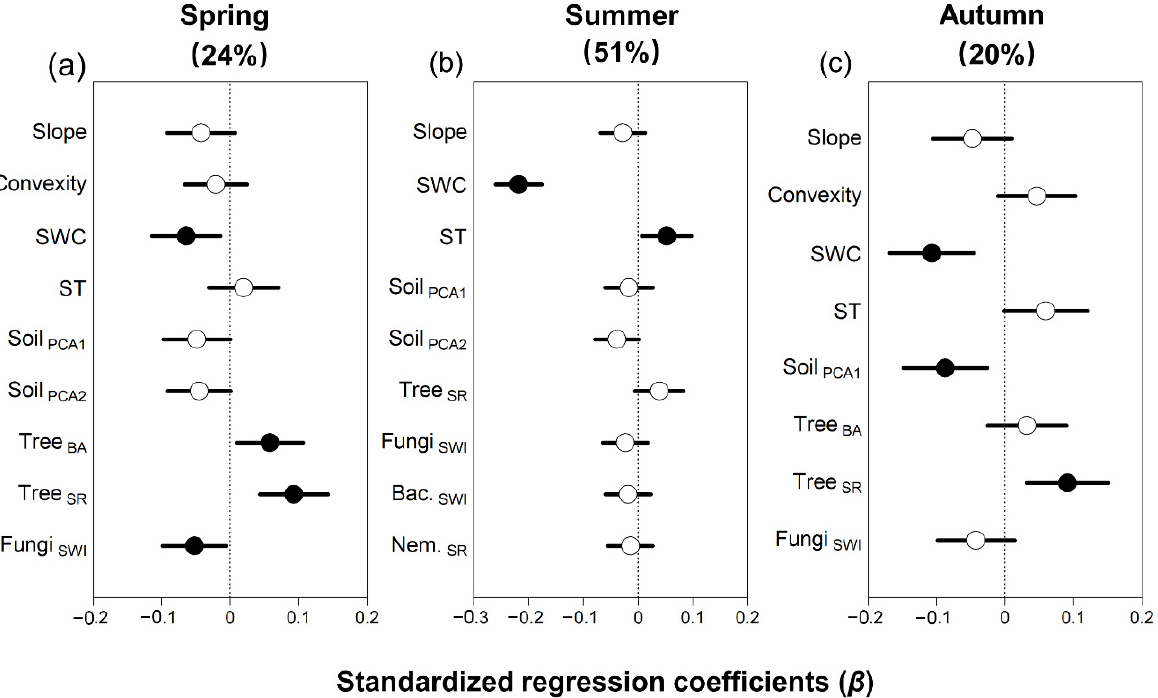
Figure 1. Standardized regression coefficients ( β ) of the biotic and abiotic predictors of soil respiration across a 25 ha forest dynamics plot in Northeast China, derived from multiple linear regression models for each season. The total R 2 is given in parentheses for each model (See also Table S5). Closed circles indicate significant relationships with soil respiration at p < 0.05, and lines indicate standard errors. All abbreviations follow Table 1.